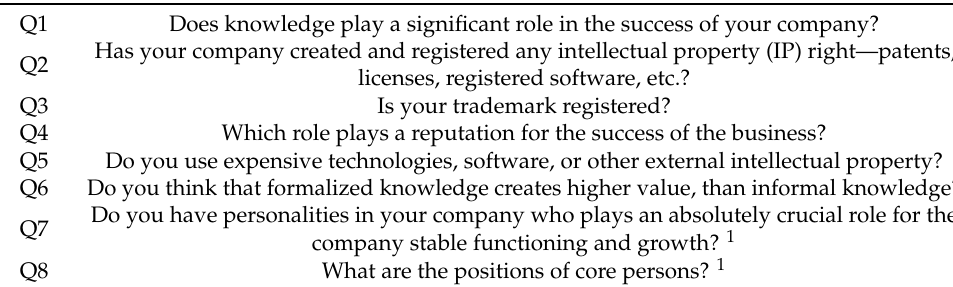
Table A1. List of questions of the